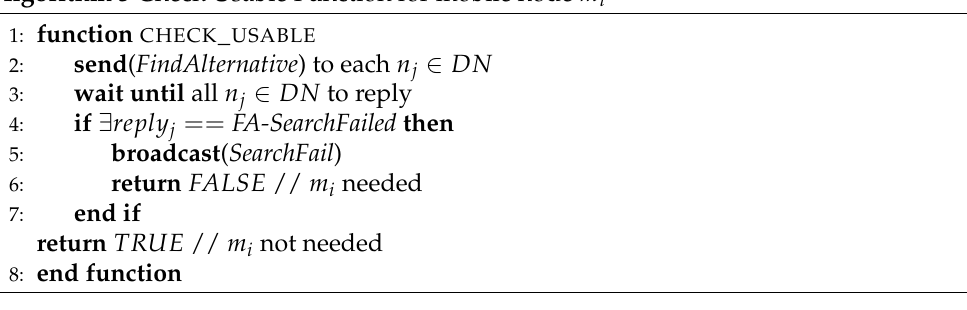
Algorithm 3 Check Usable Function for mobile node m i